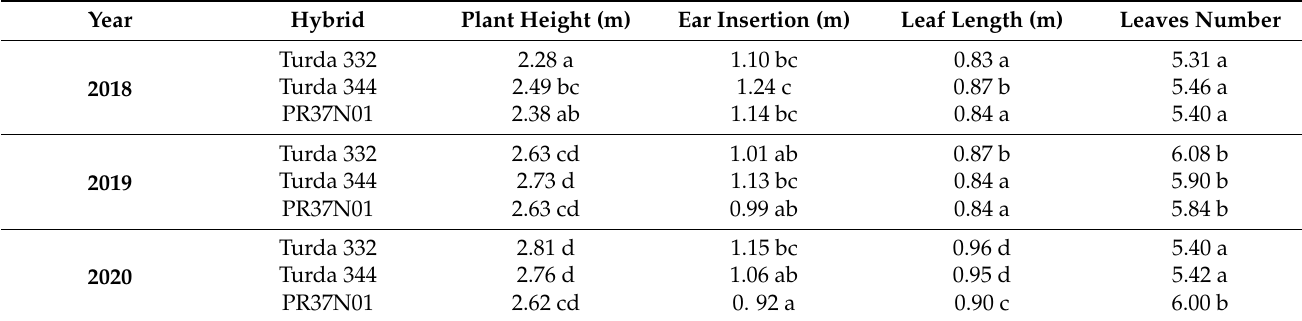
Table 2. Influence of the interaction year × hybrid on maize plant